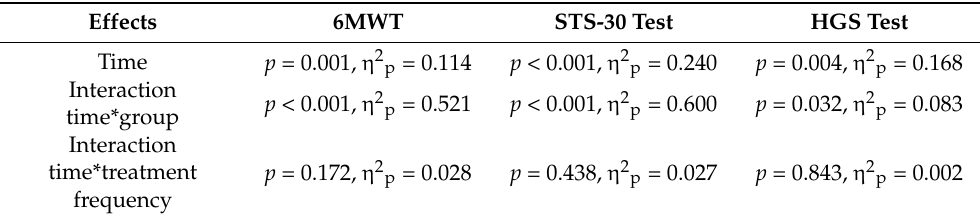
Table 3. Results of the ANOVA (time*group*treatment frequency) for 6MWT, STS-30 Test and HGS